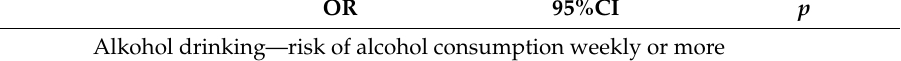
Table 3. Logistic regression analysis results for risk of alcohol consumption weekly or more, risk of current smoking cigarettes, risk of smoking more than 20 cigarettes a day, risk of drinking more than two cups a day, risk of being physically inactive for cohorts and level of education (OR, 95%CI, p ) and χ 2 , R-square and Hosmer-Lemeshow tests results. OR 95%CI